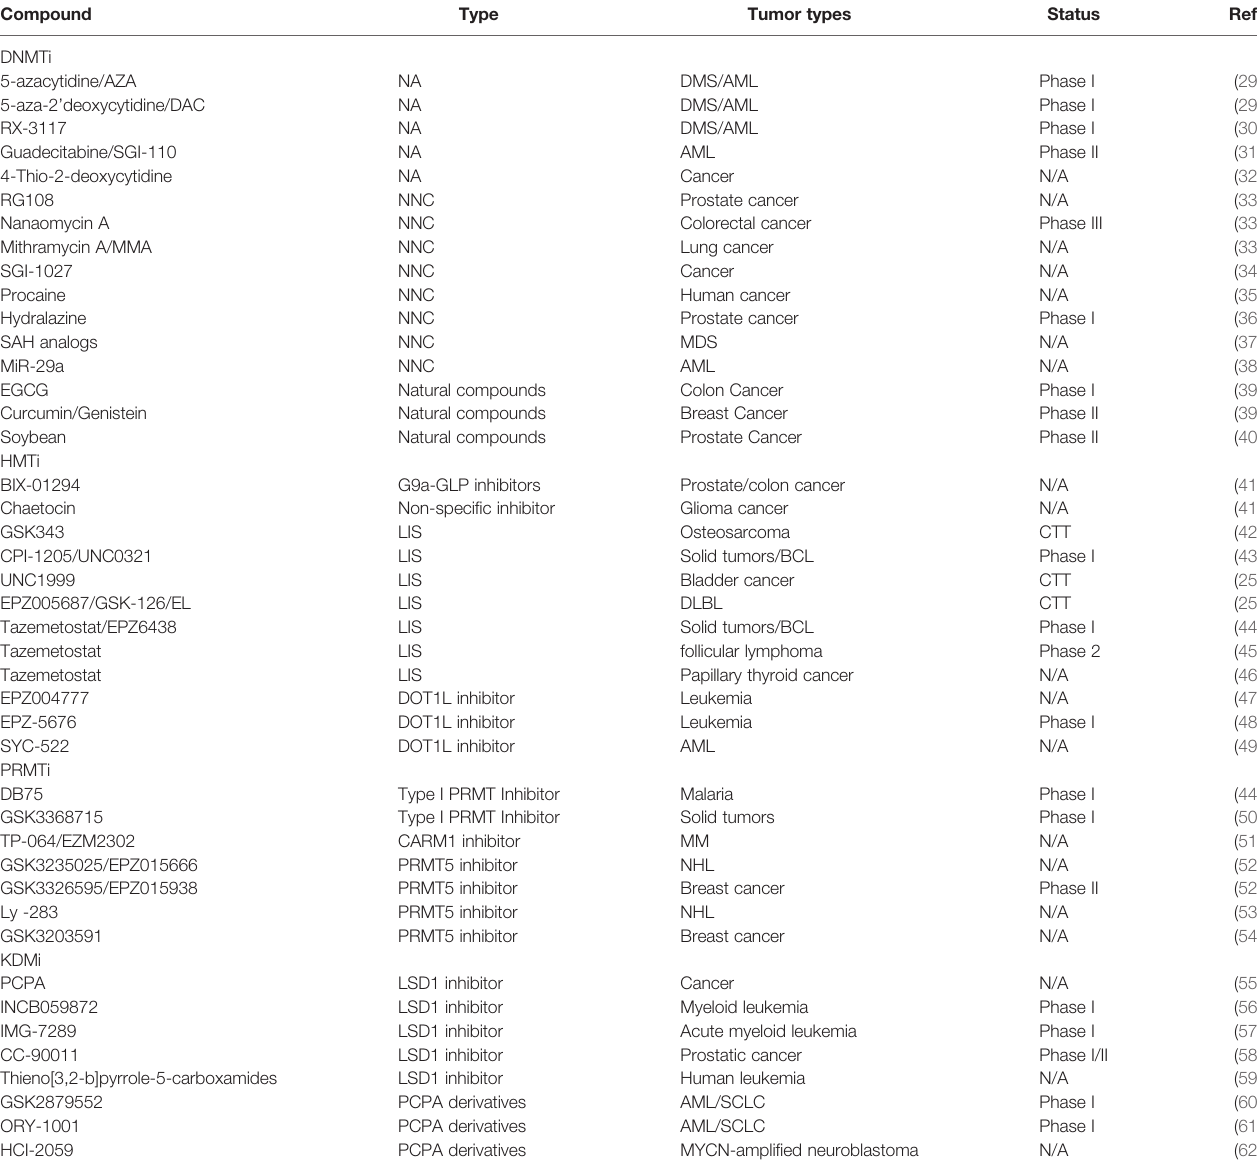
TABLE 1 | Small molecule compounds targeting epigenetic regulatory